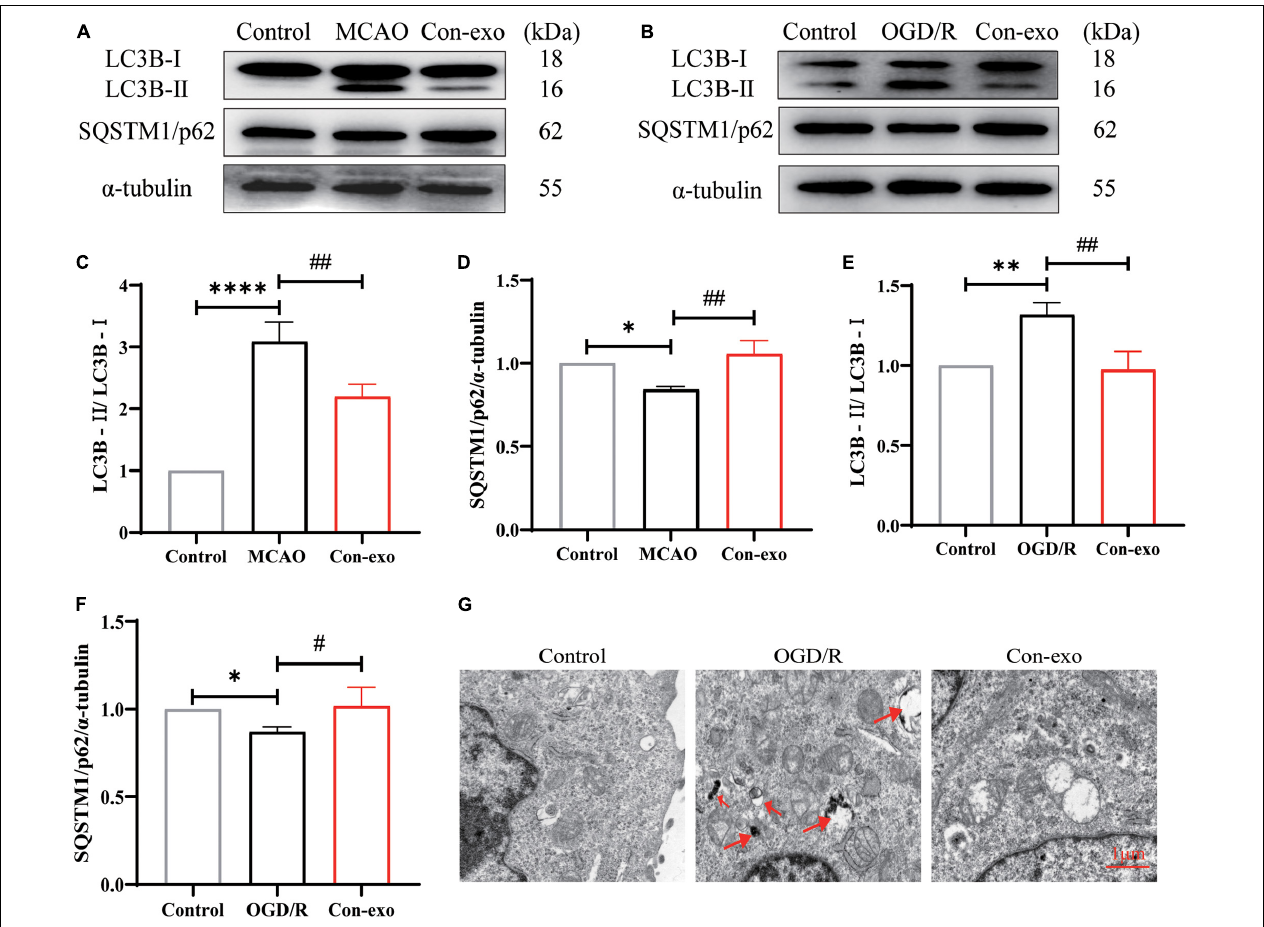
FIGURE 5 | Serum exosomes inhibit autophagy in vivo and in vitro . (A,B) Effect of Con-exo on SQSTM1/p62 and LC3B expression in the ischemic cortex (A) and bEnd.3 cells (B) as determined by Western blotting analysis. (C–F) Statistical analysis of LC3BII/LC3BI (C,E) and SQSTM1/p62 (D,F) in the ischemic cortex and bEnd.3 cells induced by OGD/R. (G) Representative TEM images of autophagic vesicles in bEnd.3 cells induced by OGD/R. * P < 0.05, ** P < 0.01, **** P < 0.0001 vs. control, # P < 0.05, ## P < 0.01 vs. MCAO or OGD ( n =